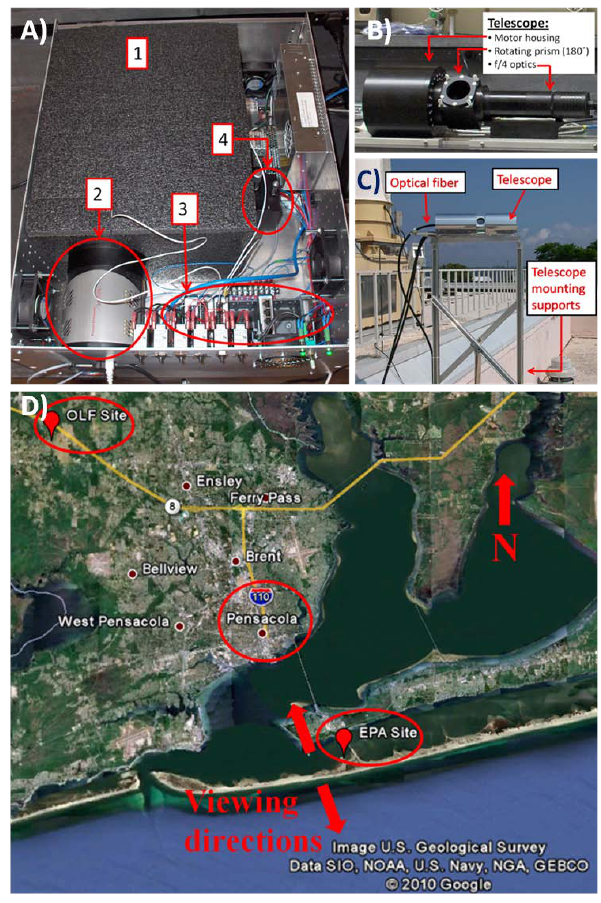
Fig. 1. (A) Instrument rack containing ACTON2356i spectrometer (1), PI PIXIS400B CCD detector (2), National Instruments Com- pact RIO with electronics modules (3), optical mounts to position fibers (4) and power supplies. (B) Telescope with housing of the MDrive34 stepper motor, rotating prism housing, and lens tube for f/4 optics. (C) Outdoor setup of telescope with solar shields to reduce heating of telescope. (D) Measurement sites: OLF lo- cated ∼ 20km northwest of Pensacola, FL, and EPA located in Gulf Breeze, FL ∼ 10km southeast of